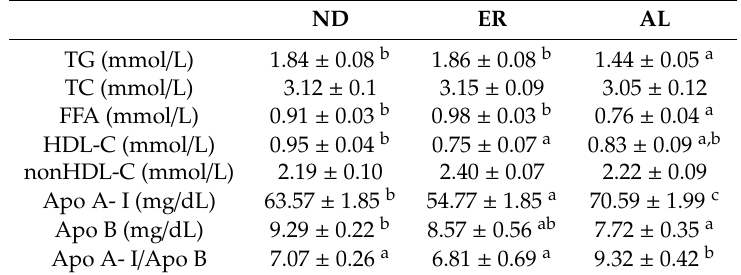
Table 1. Effect of AL supplementation for 16 weeks on plasma lipid profiles in C57BL/KsJ-db/db mice fed normal diet. Table 1. E ff ect of AL supplementation for 16 weeks on plasma lipid profiles in C57BL / KsJ-db / db mice fed normal